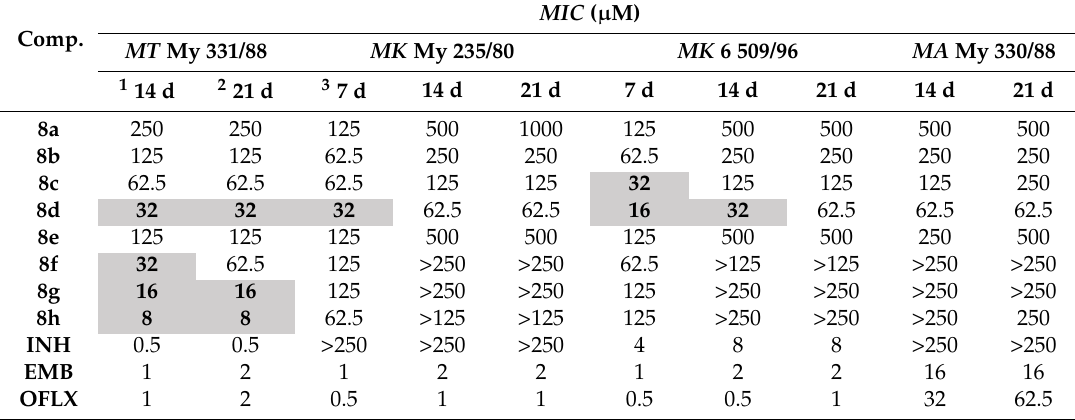
Table 4. The in vitro activity (the MIC values were expressed in the µ M units) of currently screened compounds 8a – h and reference drugs isoniazid (INH), ethambutol (EMB) and ofloxacin (OFLX)